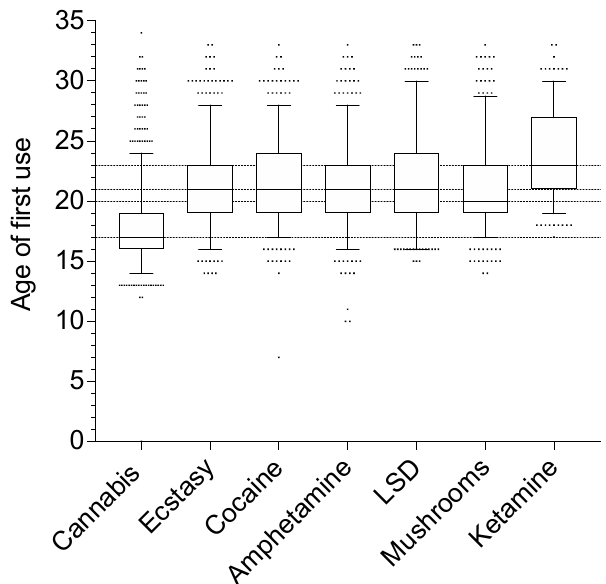
Figure 3. Age of first use of each drug. The median age of first use is shown (line) for each drug. The box shows the 25th and 75th percentiles and the whiskers show the 5th percentile. The remaining data points are shown as individual points stacked next to each other. LSD, lysergic acid diethylamide.